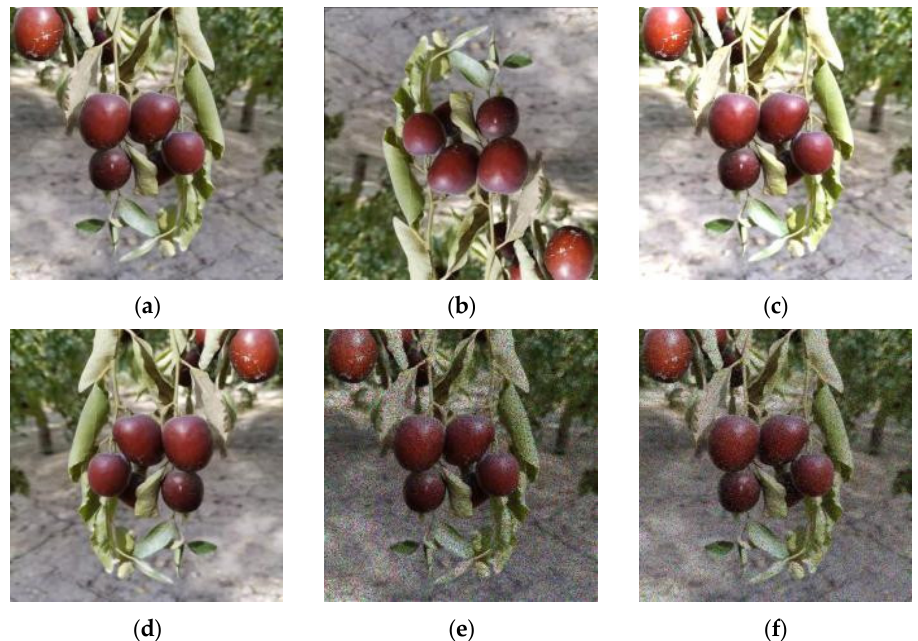
Figure 2. Image sample after data preprocessing and augmentation. ( a ) original image, ( b ) rotating by 180°, ( c ) Increasing brightness, ( d ) mirroring image , ( e ) adding noise , ( f ) reducing brightness